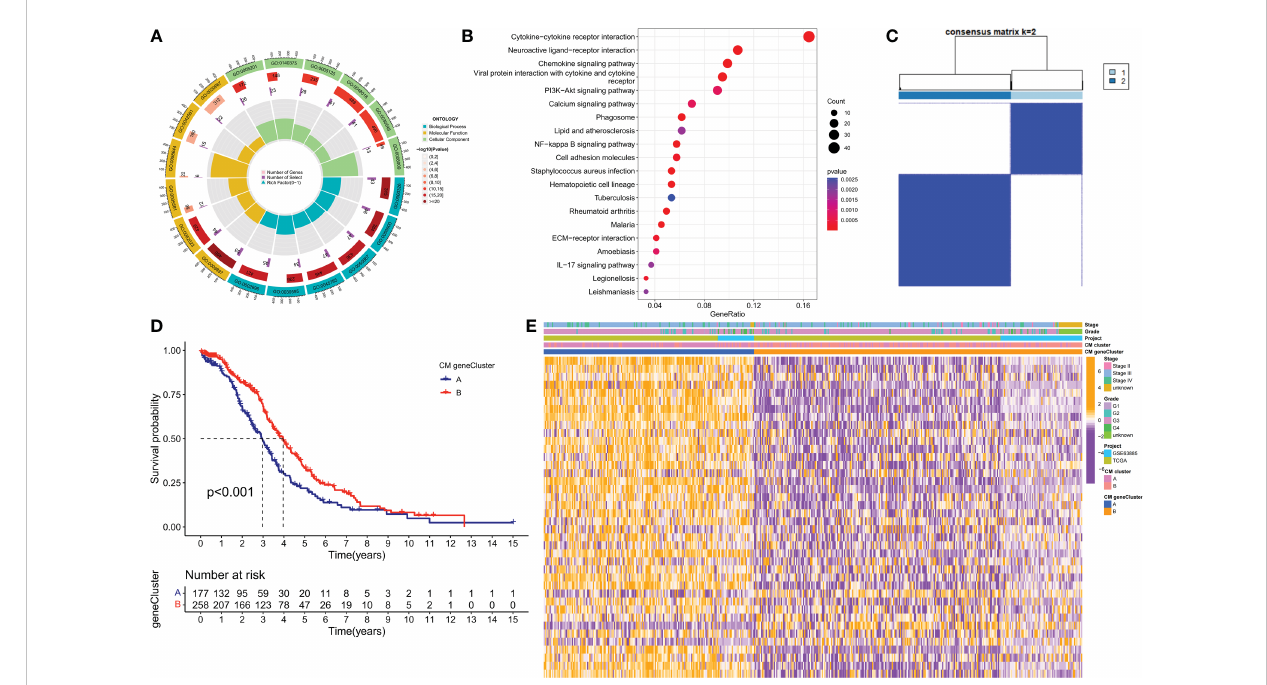
FIGURE 4 Identi fi cation of CM gene clusters based on differential genes (DEGs) in CM clusters. (A, B) GO and KEGG enrichment analysis of DEGs in two CM clusters. (C) All samples from the TCGA-OV cohort and the GSE63885 cohort were divided into two CM gene clusters using a consensus